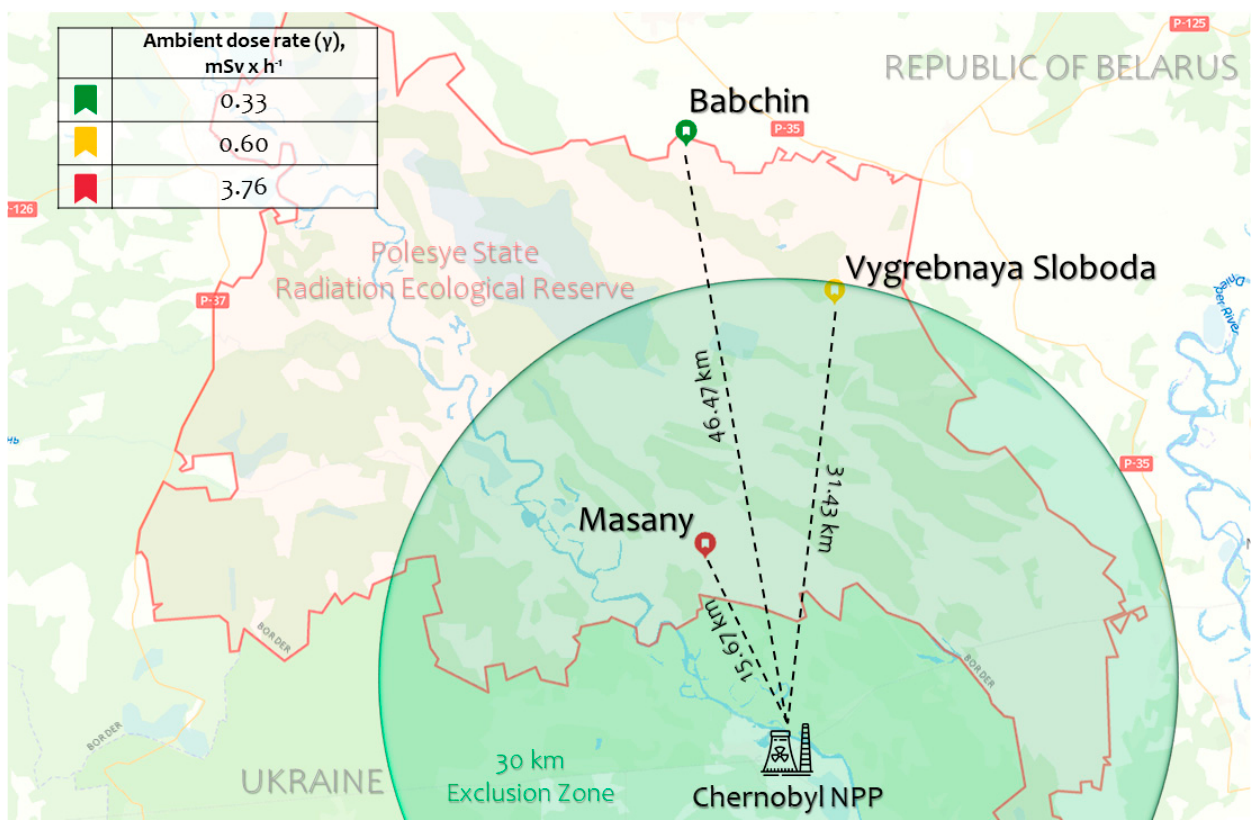
Figure 1. Map of the experimental plots (Babchin, Vygrebnaya Sloboda, and Masany) located in the Polesye State Radiation-Ecological Reserve (Khoiniki, Gomel Region, Republic of Belarus) where A . thaliana Bab-0, VS-0, and Masa-0 natural accessions, respectively, were collected. The dose rates are represented in Table 1. The map was created using Google Maps (Google LLC, Mountain View, CA, USA), and adapted with Microsoft PowerPoint 2019 (Microsoft Corporation, Albuquerque, NM, USA). Table 1. Soil properties of the experimental plots.